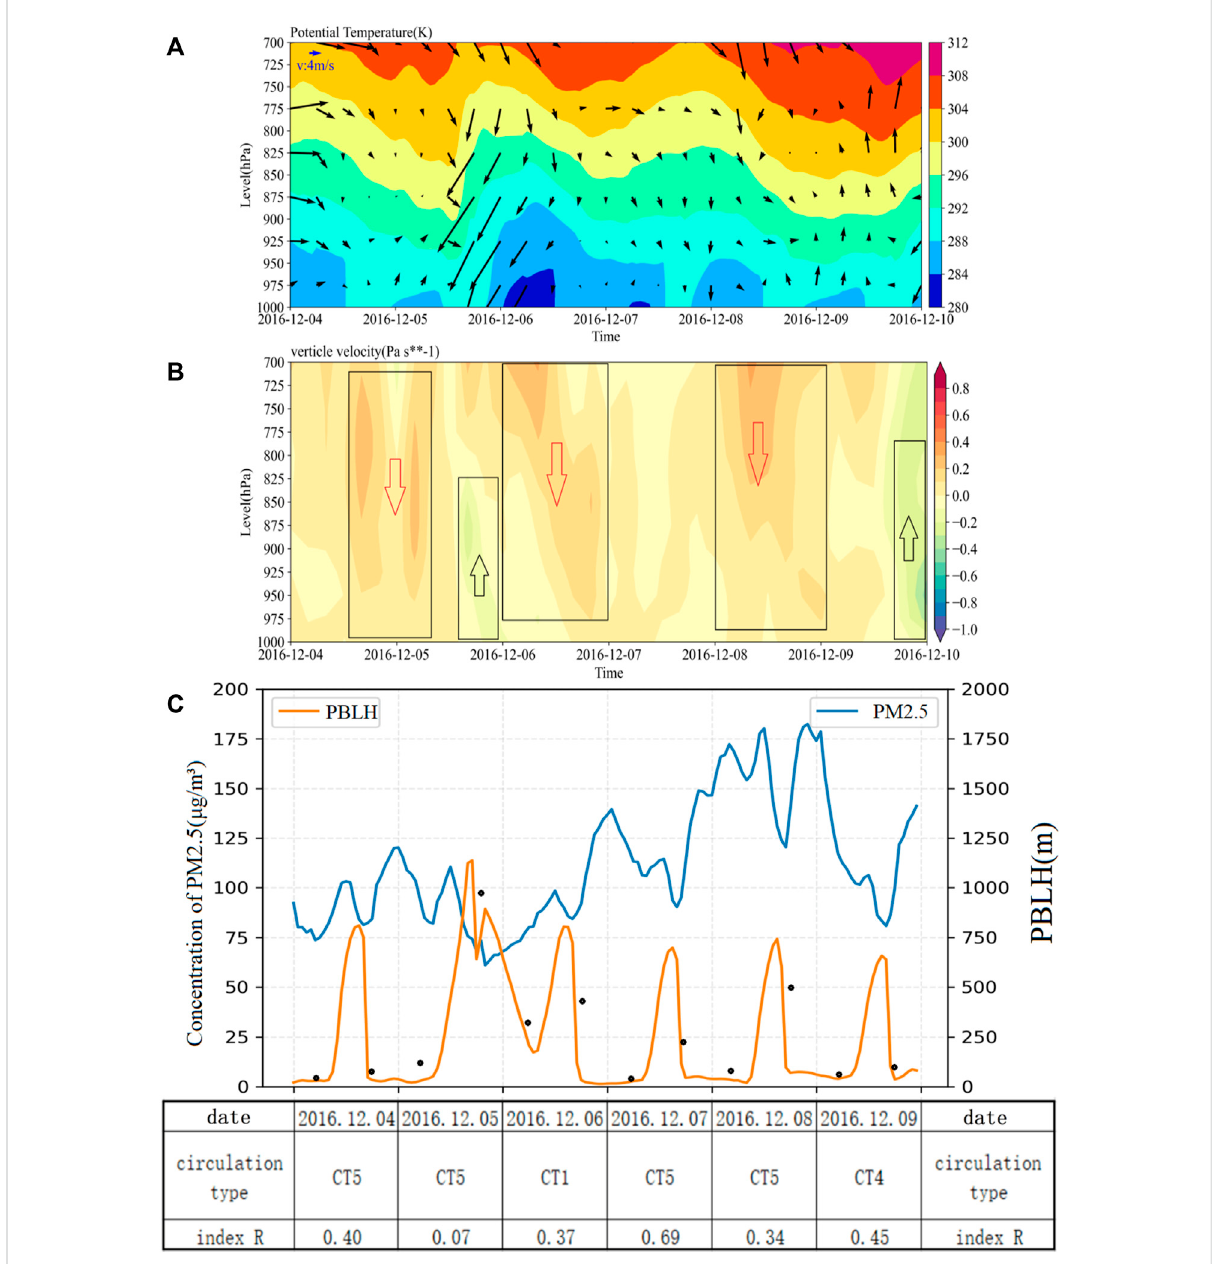
FIGURE 12 Plots showing a recirculation process that occurred in Changsha in December 2016. (A) Time series of the vertical geopotential temperature pro fi le and the horizontal wind fi eld in the Changsha area during the recirculation process. (B) Time series of the vertical wind speed pro fi le in the Changsha area during the recirculation process, in which the red arrows represent downdraft, and black arrows represent updraft. (C) Time- dependent changes of the boundary layer height and PM 2.5 concentration, as well as daily circulation patterns and R values in Changsha during the re fl ow process. Black dots represent the PBLH observed from the sounding data. The boundary layer height, geopotential temperature, horizontal wind fi eld, and vertical wind speed in the fi gure have been obtained from the output of the WRF